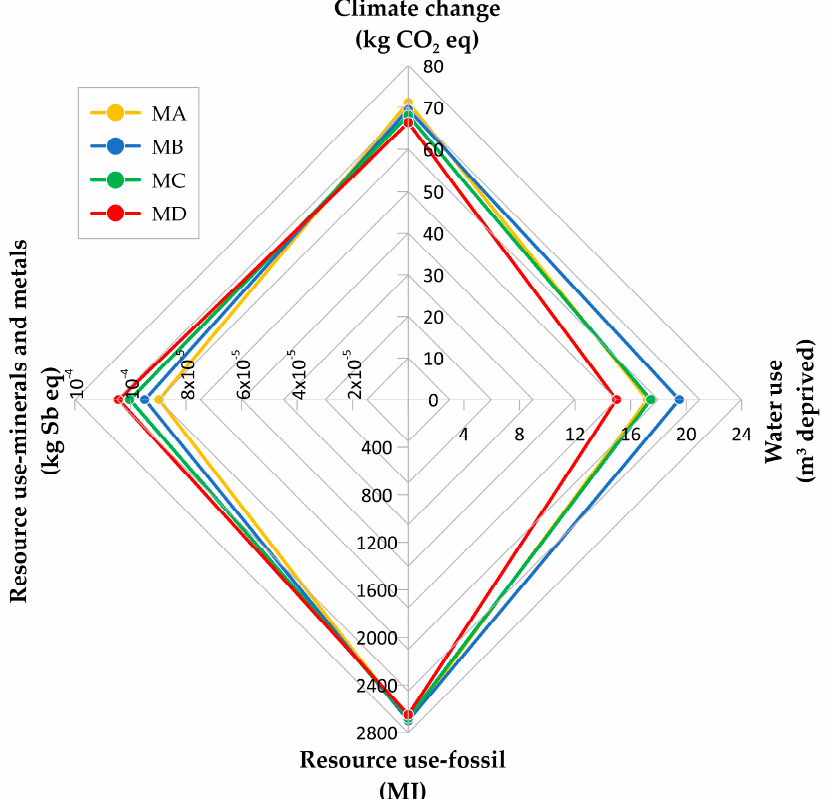
Figure 11. Mi LCIA